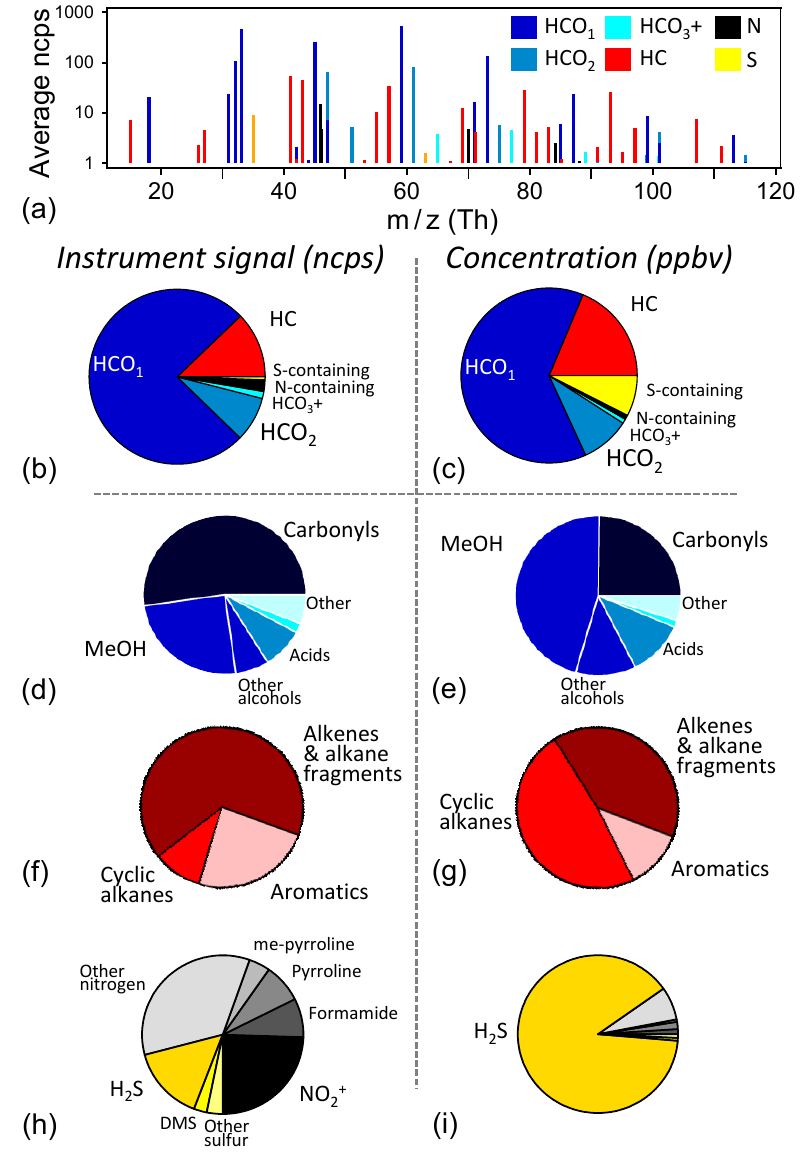
Figure 5. Overview of H 3 O + ToF-CIMS mass spectra measured during the 23 April Permian flight. The categories “HC”, “HCO 1 ”, “HCO 2 ”, etc. mean hydrocarbon species (without S or N) with no oxygen, with one oxygen atom, with two oxygen atoms, etc. Top: average mass spectrum, colored by elemental composition. Large pie chart: overall VOC composition. Color code is the same as mass spectrum. Small pie charts: composition of oxygenated (top), HC-only (middle), and N- and S-containing species (bottom). For all pie charts, the composition in terms of both relative instrument signal (ncps, left column) and mixing ratio (ppb, right column) is shown. See text for a description of which species were included in the mixing ratio charts and how concentrations were